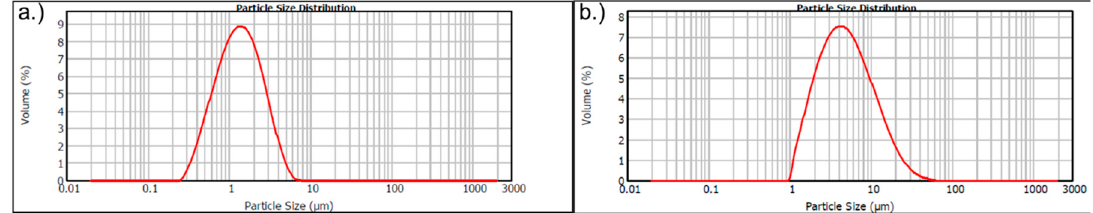
Figure 1. Particle size distribution of ( a ) titanium dioxide, and ( b ) MK.